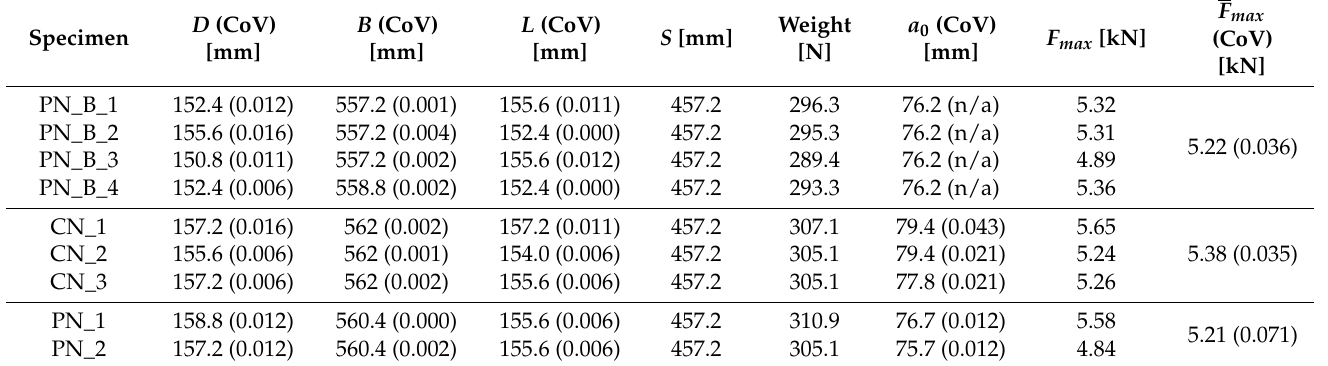
Table 2. Specimen dimensions and peak